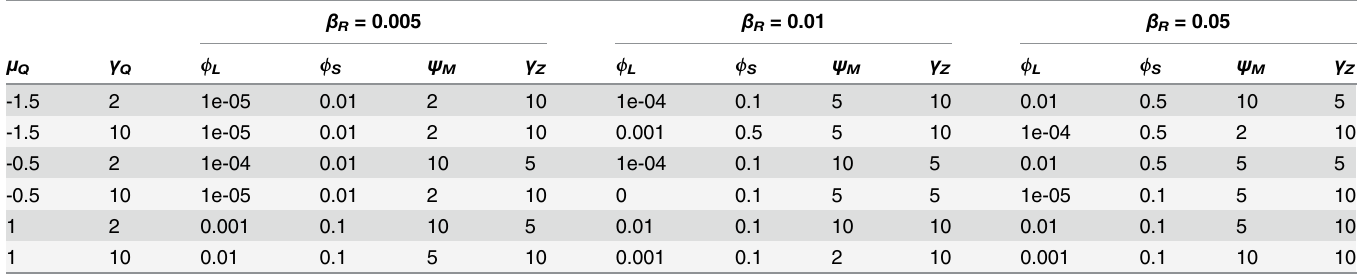
Table 4. Best performing memory parameters ( ϕ L , ϕ S , ψ M , γ Z ) for each landscape environment, a combination of regeneration rate ( β R ), patch con- centration ( μ Q ), and patch size ( γ Q